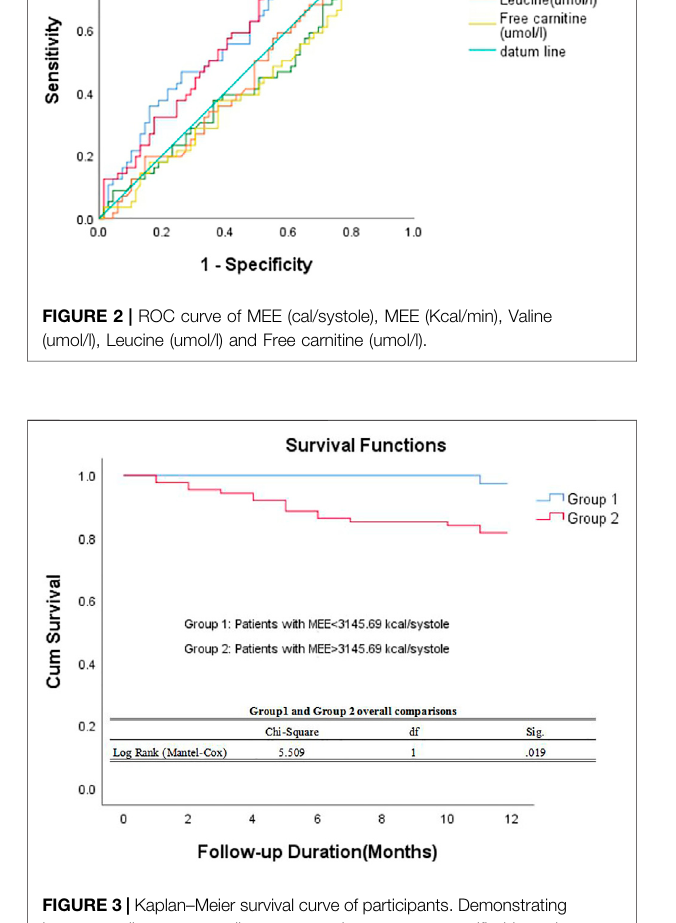
FIGURE 3 | Kaplan – Meier survival curve of participants. Demonstrating long-term all-cause mortality among patients groups speci fi ed based on myocardial energy expenditure cut-off value 3145.69 kcal/systole. MEE myocardial energy expenditure.